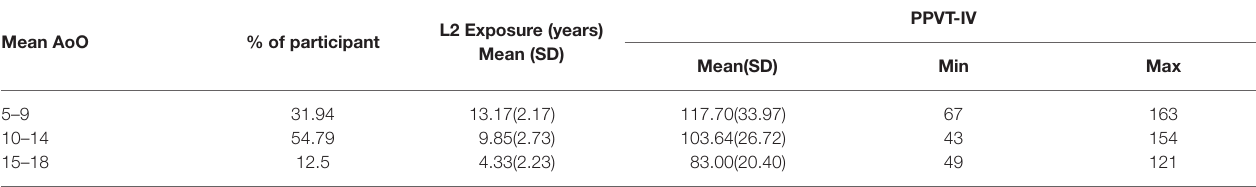
TABLE 1 | Means and standard deviations of L2 exposure, age of onset (AoO), and PPVT-IV scores. Mean AoO % of participant